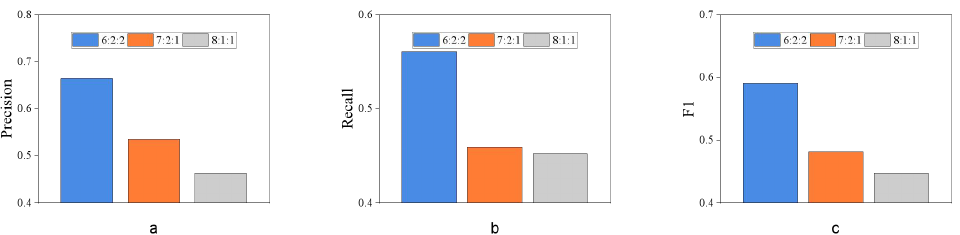
Figure 11. The experimental results of the three division ratios. ( a ) Precision. ( b ) Recall. ( c )